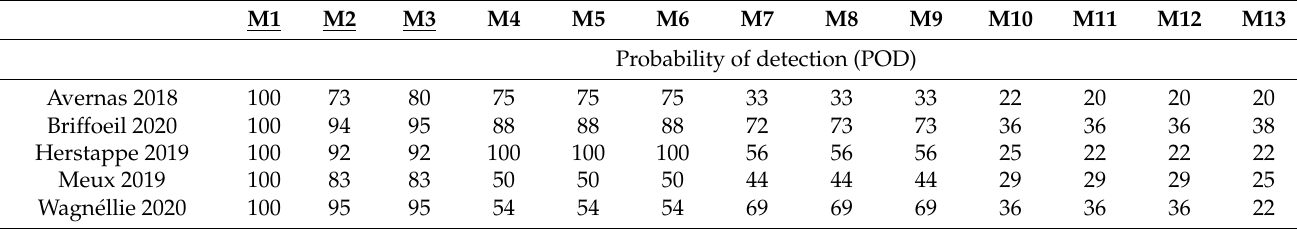
Table 5. Statistical contingency scores for the three best performing weather-based models during the testing phase. M1–13: model #1 to model #13, respectively. POD: probability of Cercospora leaf spot detection (best score = 100%); FAR: false alarm ratio (best score = 0%); CSI: critical success index (best score = 100%). The 3 best performing models are underlined (M1, M2 and M3). All the POD, FAR, and CSI values for model M14 were 0 (no simulation achieved based on the combined weather conditions defined for that model); the statistics were therefore not